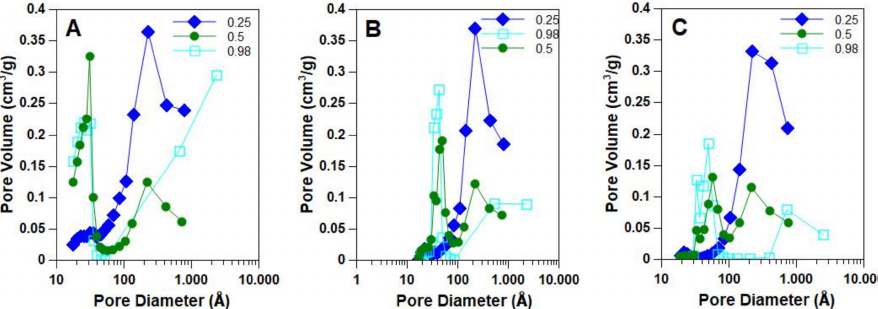
Figure 3. Comparison of pore size distribution of samples prepared with a S/C molar ratio of 0.25, 0.5, and of 0.98: ( A ) after calcination at 500 ◦ C; ( B ) after calcination at 800 ◦ C; ( C ) after impregnation of Ni and calcination at 800 ◦ C.